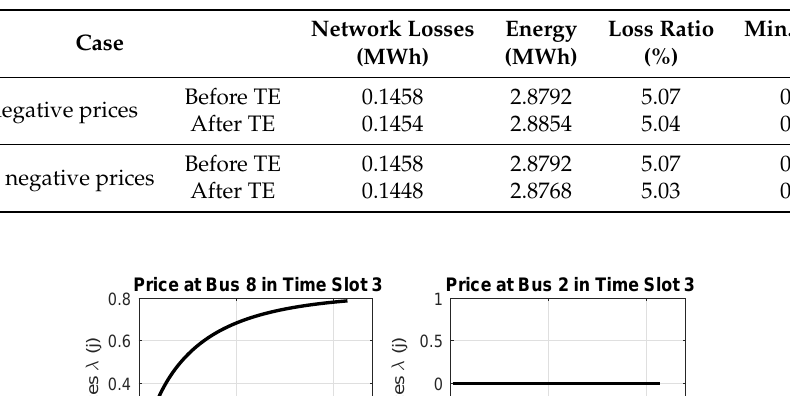
Table 2. Overview of network conditions.